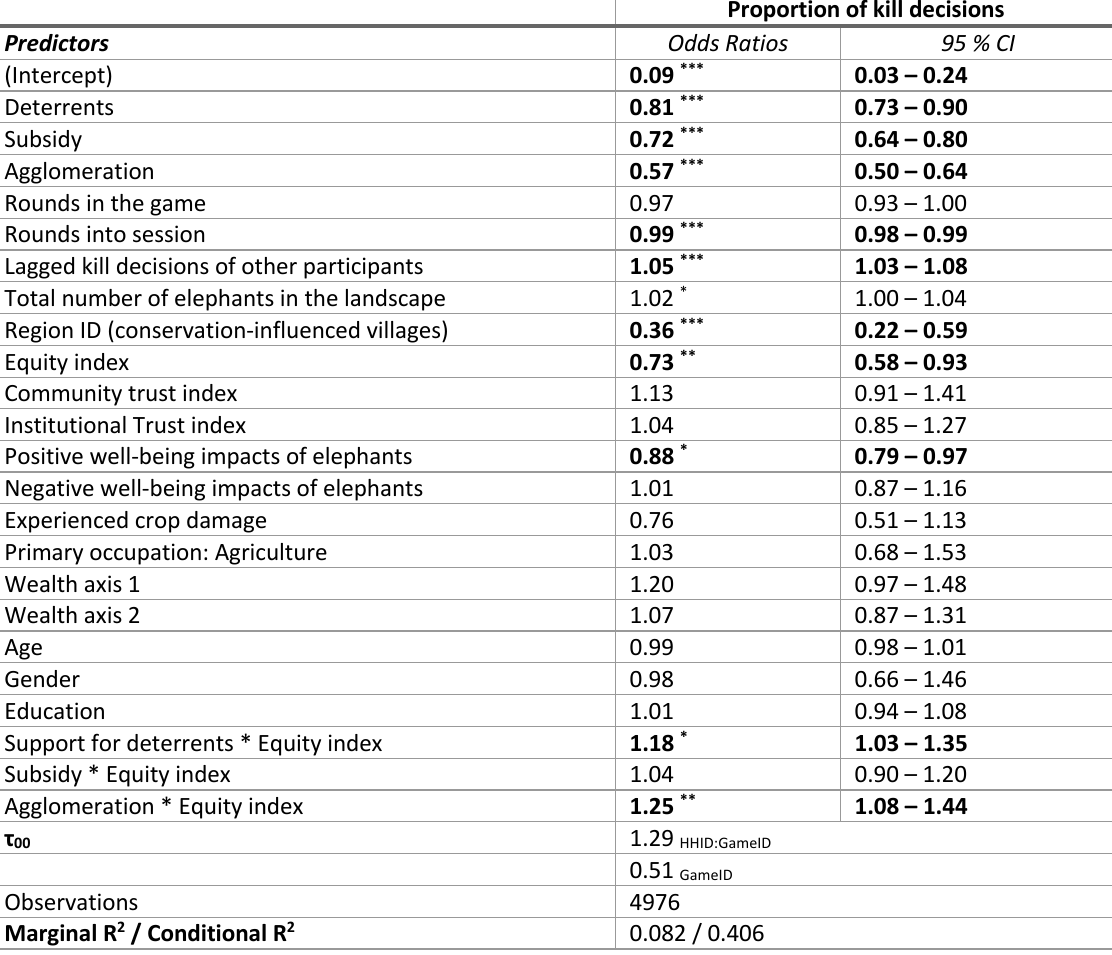
Table A1.4: Odds ratio estimates from the full GLMM model showing the effect of treatments and other households’ characteristics on farmers’ propensity to kill elephants in the games. Random effects included in the model were individuals and groups.